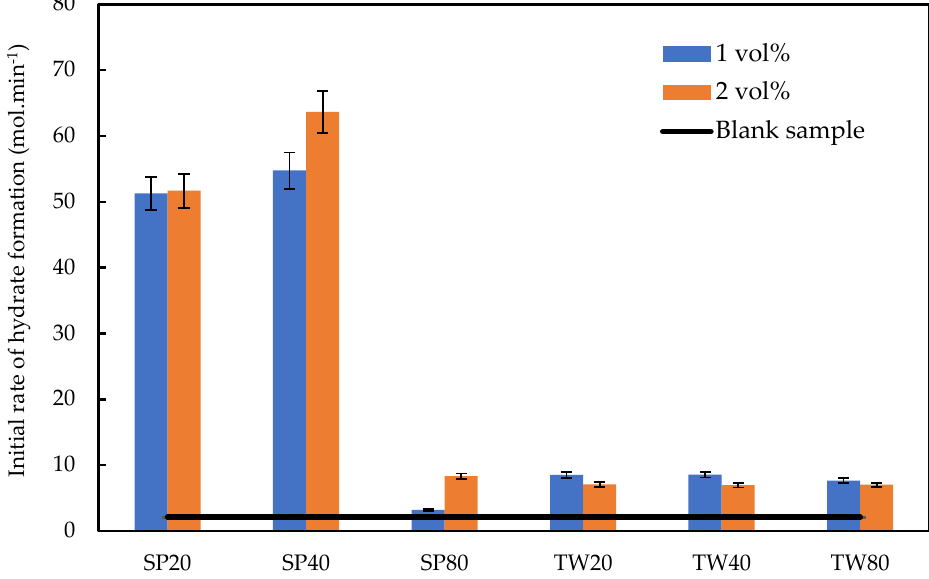
Figure 7. Initial rate of CH 4 hydrate formation in the presence of non-ionic surfactants. (Oil/H 2 O: 50/50; 277 K, 8.50 MPa).